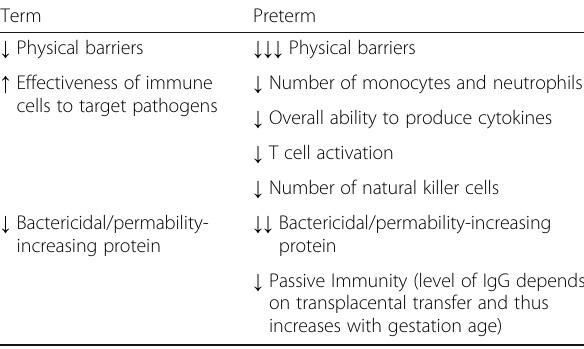
Table 1 Comparison of the Term and Premature Neonatal Immune